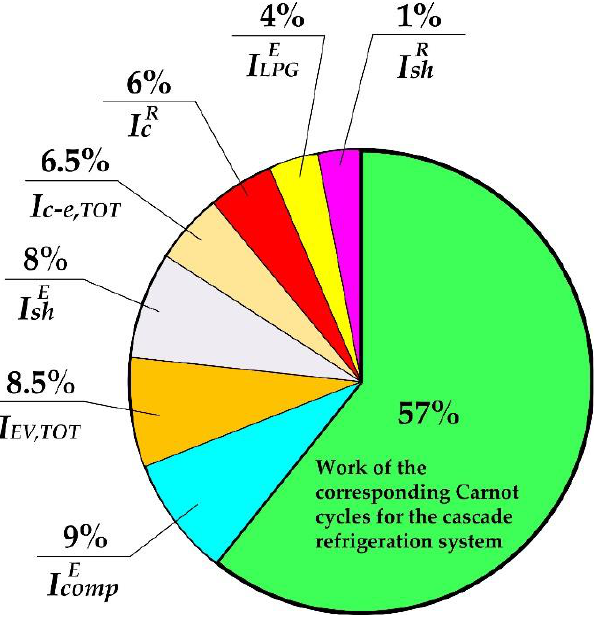
Figure 9. A graphical interpretation of the results of the thermodynamic performance assessment.